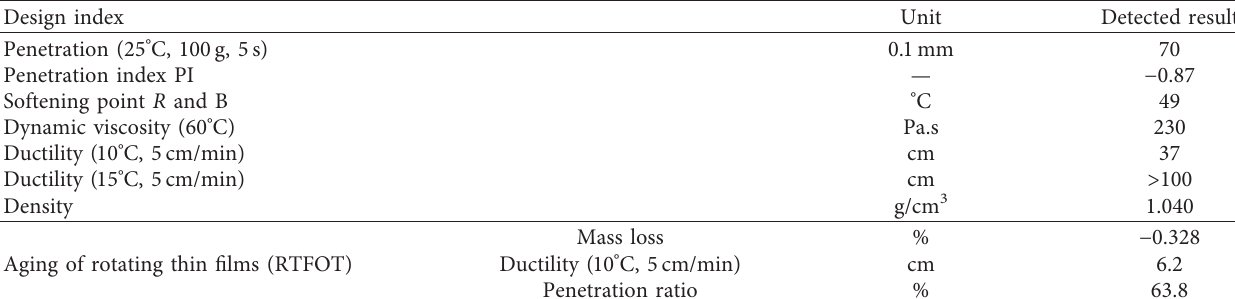
Table 1: Performance indices of 70 # asphalt.